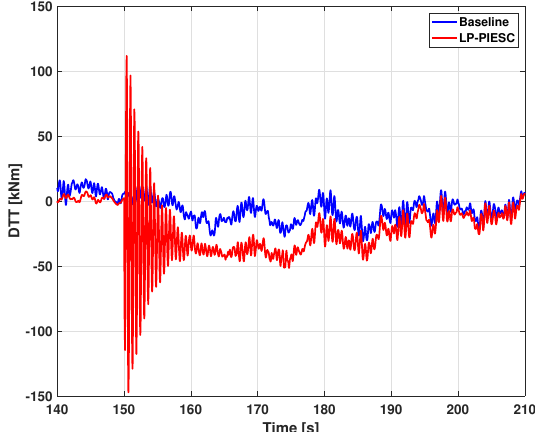
Figure 14. Drivetrain Torsion (DTT) time series of baseline (blue) and LP-PIESC (red) for the 4 m/s wind profile in Figure 6. Sudden change in generator torque at LP-PIESC start, i.e., 150 s leads to an increase in the amplitude of the drivetrain torsional moment. Once the transients die out, it follows the baseline.